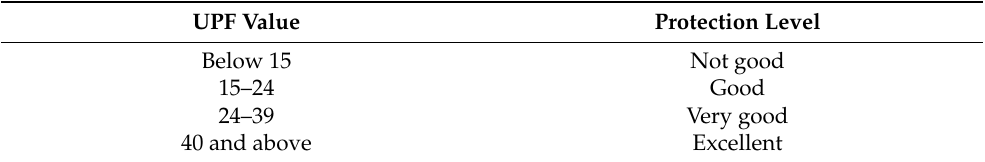
Table 7. UPF value and protection category of fabric categorized by The Australian Standardization Institute.